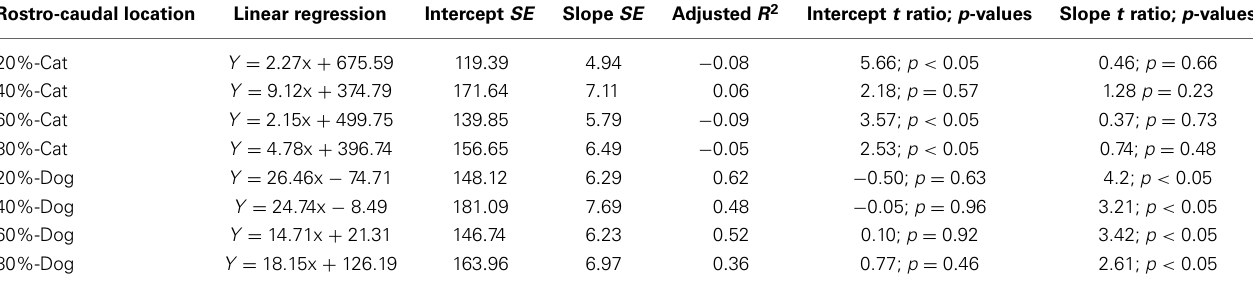
Table 3 | Summary of statistical parameters for progenitor cells per ventricular surface mm 2 regressed against translated age in cats and dogs. Rostro-caudal